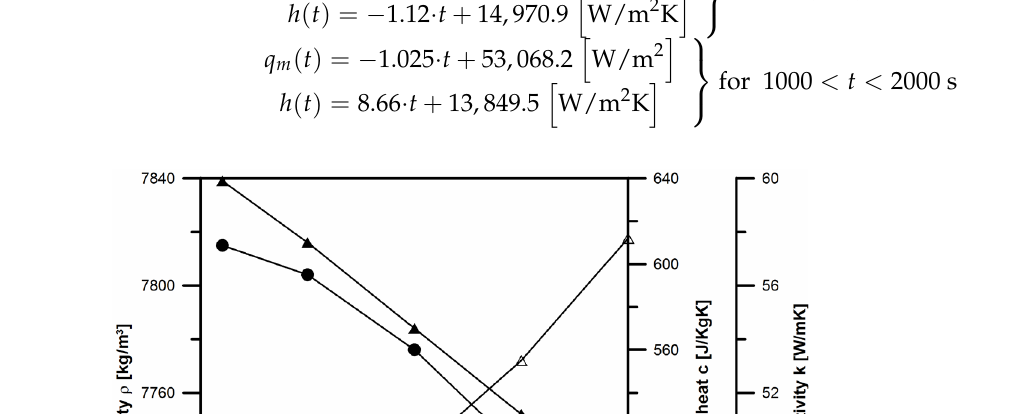
Figure 9. Cross-section of the membrane wall with a flux tube in the steam boiler combustion chamber: 1—waterwall tube, 2—flux tube, f 1 – f 5 —location of thermocouples to measure temperature.